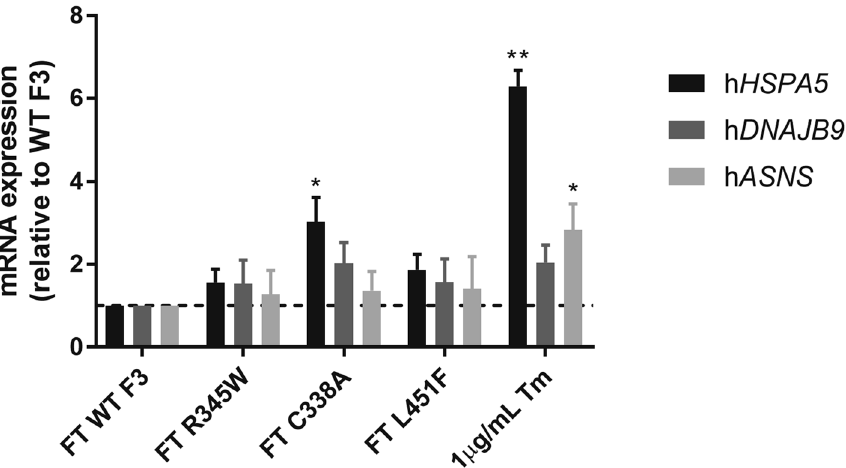
Figure 3. L451F does not elicit an ER stress response. qPCR analysis of h HSPA5 , h DNAJB9 , and h ASNS transcript levels with TaqMan probes in WT F3, R345W, C338A, L451F–expressing HEK293A cells and cells treated with 1 μg/mL tunicamycin (Tm), 24 h. n = 3, mean ± SEM (* p < 0.05, ** p < 0.01, one sample t test vs. a hypothetical value of 1 [i.e.,